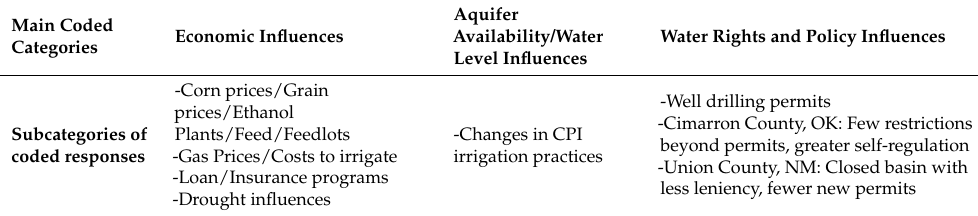
Table 2. Factors influencing center pivot irrigation (CPI) growth: primary coded categories from key informant interview responses in Cimarron County, OK and Union County, NM ( n =